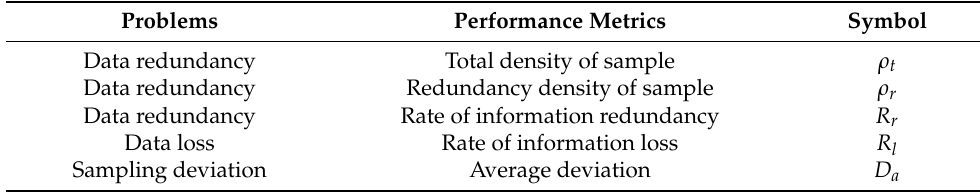
Table 2. Performance metrics and their representation.